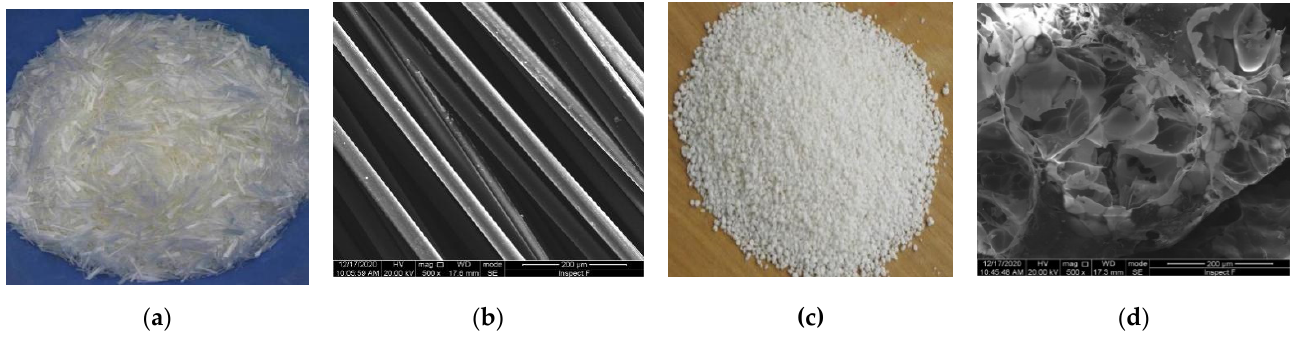
Figure 1. Materials: ( a ) PVA fibers; ( b ) SEM image of PVA fiber; ( c ) GHB; ( d ) SEM image of GHB. Table 1. The properties of PVA fiber.